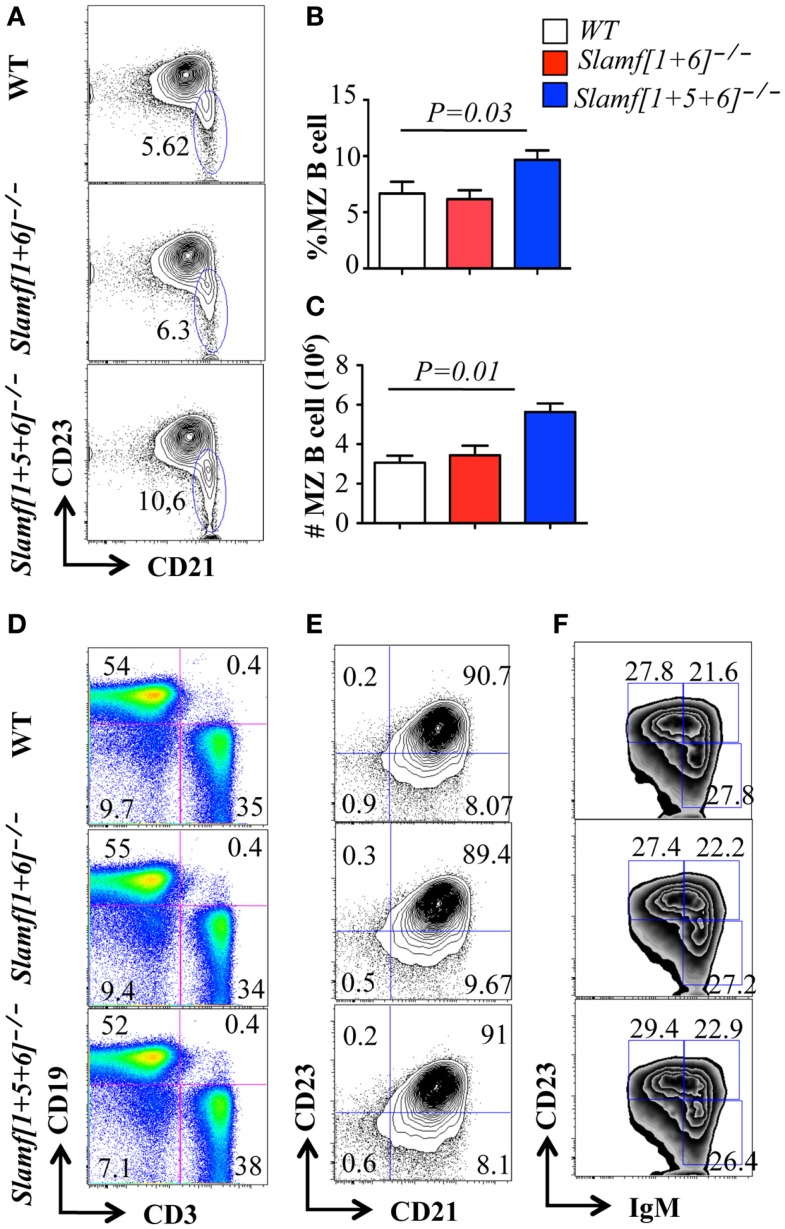
Comparison of B cell and T cell populations in Slamf[1 + 5]−/−, Slamf[1 + 5 + 6]−/−, and WT mice. Flow cytometric analyses of B cell and T cell subsets in the spleens of Slamf[1 + 6]−/−, Slamf[1 + 5 + 6]−/−, and WT mice: (A) CD19+AA4-IgMhi cells in spleens are gated for the expression of CD23 and CD21 to delineate CD21+CD23- marginal zone (MZ) B cells. (B) Percentage of CD19+AA4− IgMhiCD21+ CD23− MZ B cells. (C) The number of CD19+AA4− IgMhiCD21+CD23- MZ B cells. (D) Splenocytes from Slamf[1 + 6]−/−, Slamf[1 + 5 + 6]−/−, and WT mice are stained for surface expression of CD3 and CD19. (E) CD19+ AA4− IgMhiCD21 cells in spleens are gated for the expression of CD23 and CD21 to delineate CD21+CD23+ follicular B cells in the spleens. (F) Transitional B cell subsets in spleens are stained for the expression of CD19, AA4.1, CD23, and IgM: T1 (CD19+AA4+IgMhiCD23-), T2 (CD19+AA4+IgMhiCD23+), and T3 (CD19+AA4+IgMloCD23-).